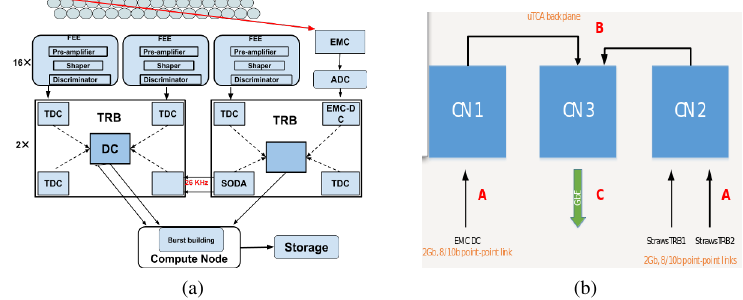
Figure 1: (a)-The general view of the DAQ architecture. The FEE is connected to the Data Concentrators which receive packets from SODAnet. and (b) Schematic representation of the compute node